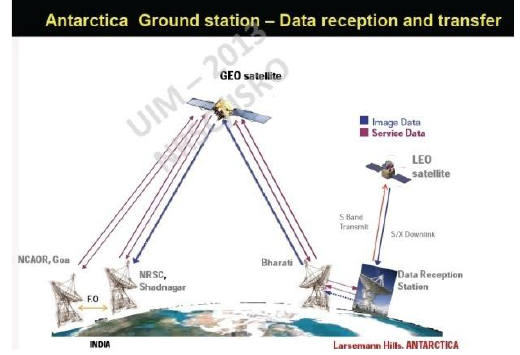
Figure 2. IMGEOS and AGEOS Communication link